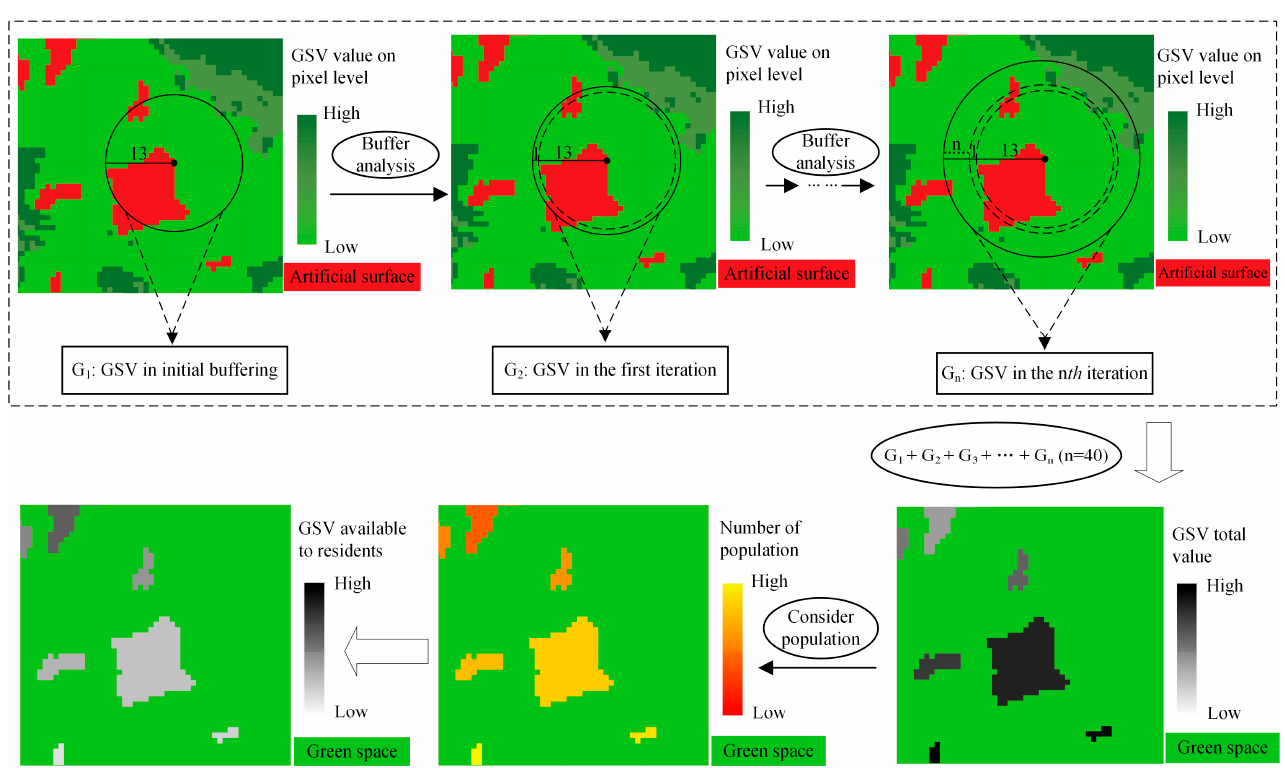
Figure 4. Quantification program of GSV available to residents. Table 1. Pixel values of different types of green space.